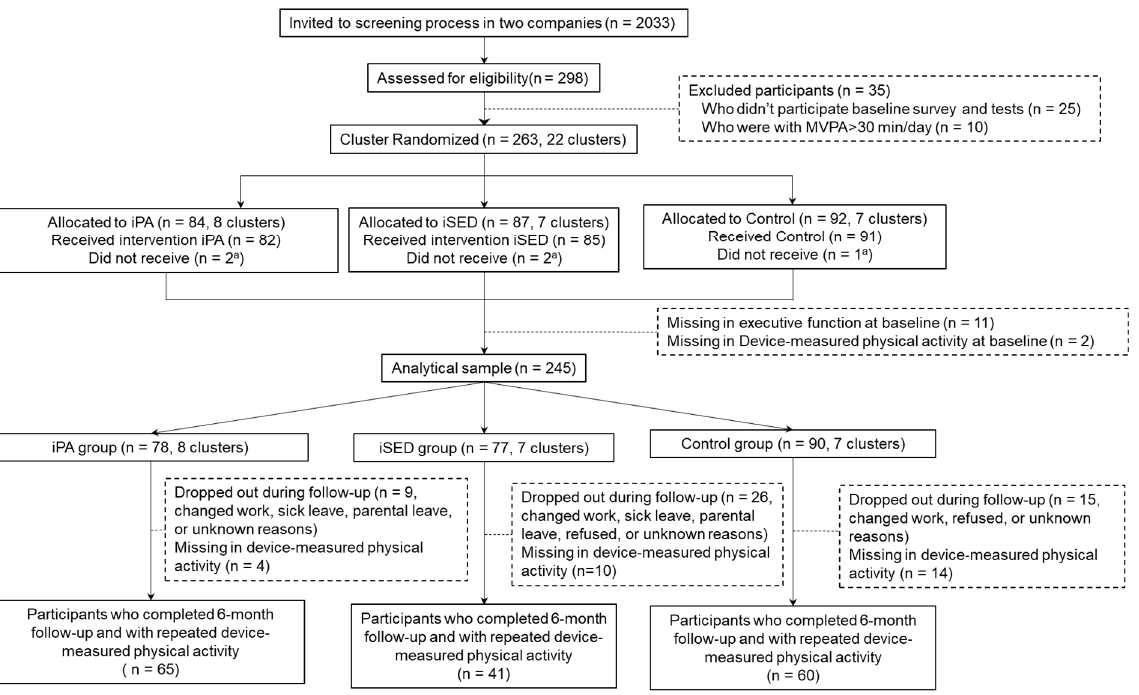
Figure 1. Flow chart of study participants in the multi-component intervention targeting physical activity and sedentary behavior. a Those who did not receive interventions were because they dropped out before notified of group allocation, or changed work during the intervention period.